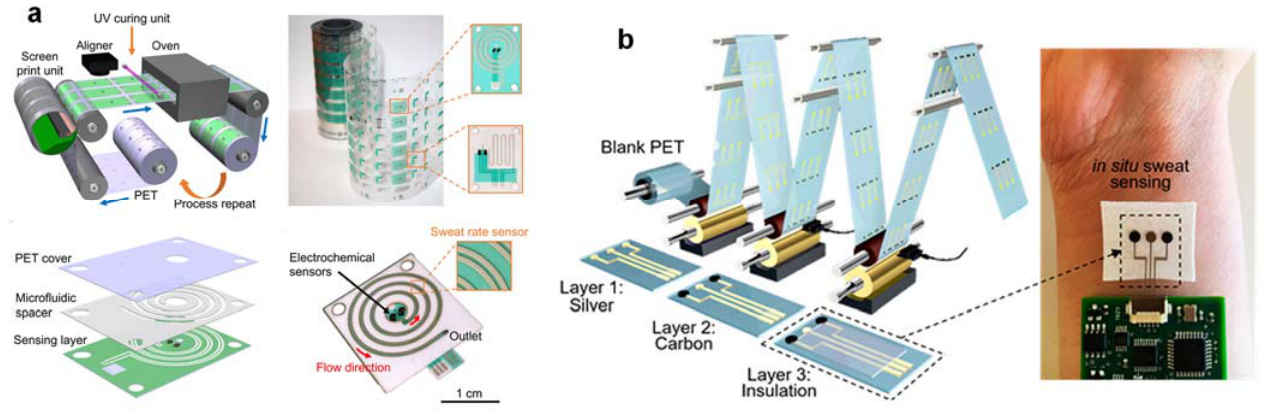
Figure 6. ( a ) Regional and correlative sweat analysis using microfluidic high ‐ throughput sensing patches to decode sweat. ( b ) Roll ‐ to ‐ roll electrochemical sensors for wearable and medical devices. patches to decode sweat. ( b ) Roll-to-roll electrochemical sensors for wearable and medical devices. The figures are reprinted with permission from ref [51,52] . The figures are reprinted with permission from ref